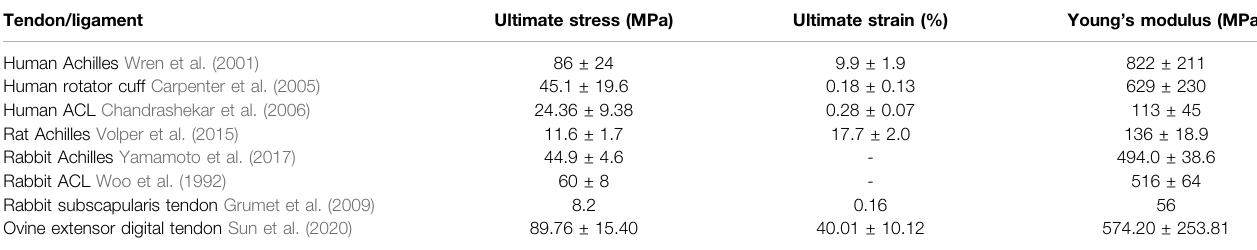
TABLE 1 | Mechanical properties of tendon/ligament in different species. Tendon/ligament Human Achilles Wren et al.